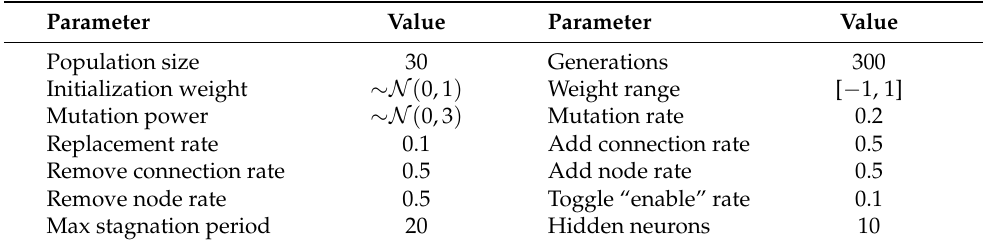
Table 5. Parameters used for the NEAT algorithm.